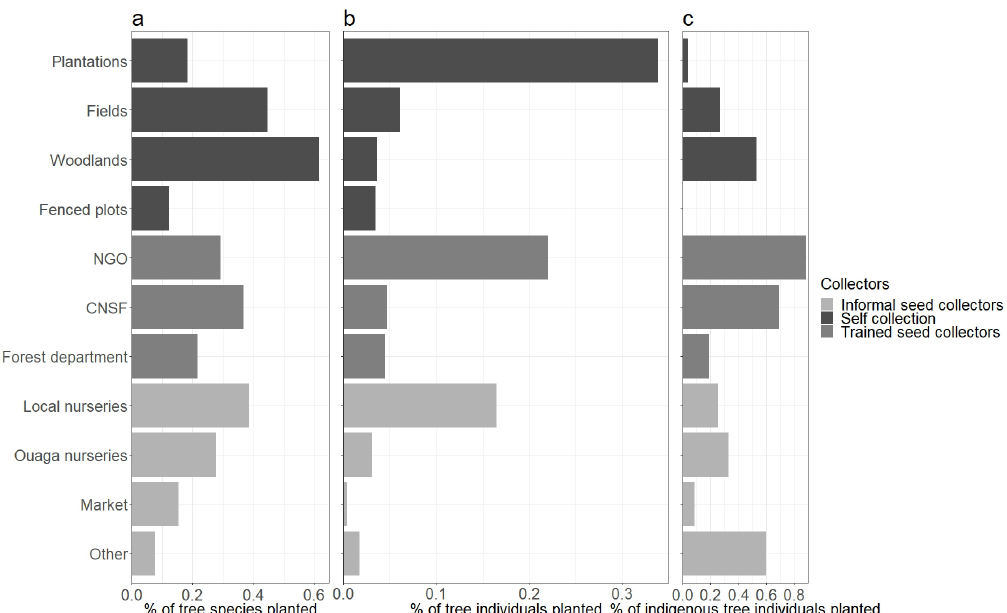
Figure 5. Barplots representing ( a ) percentage of the overall 64 tree species planted by type of source, some species being present in several categories (the sum is more than 100%), ( b ) percentage of tree individuals planted by type of seed source (the sum of all seed sources equals 100%), ( c ) percentage of indigenous tree individuals by type of seed source (the sum is more than 100%), Three categories of seed sources (characterized by different colors) are identified based on the expected level of training of seed collectors.